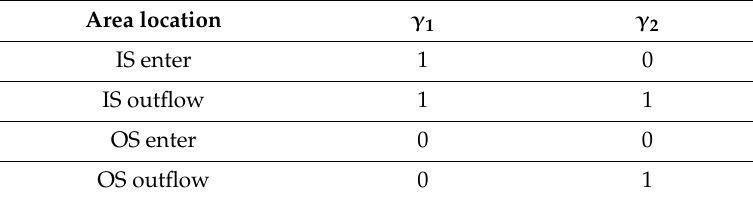
Table 4. Method for designation of measured area on kerf